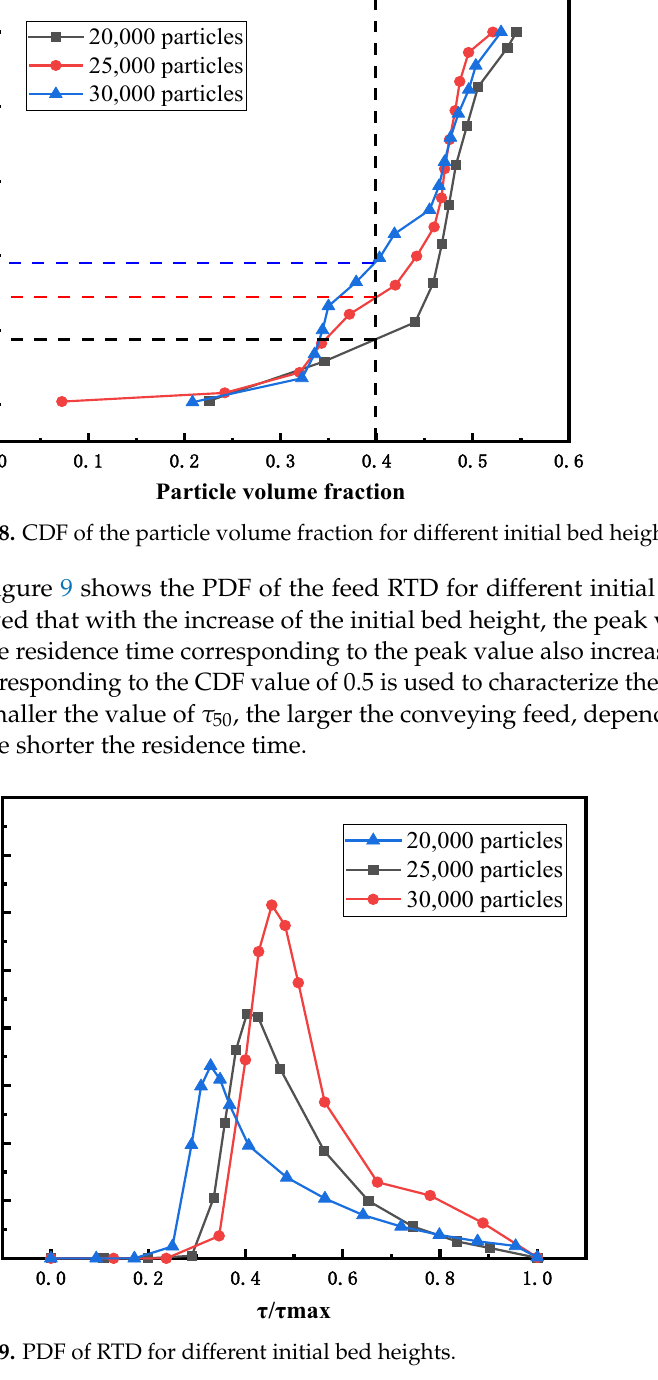
Figure 9. PDF of RTD for different initial bed heights.